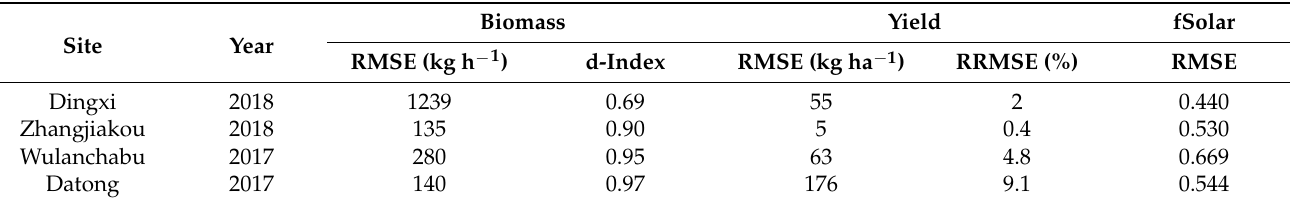
Table 6. Statistics for the evaluation of the SIMPLE-Flax